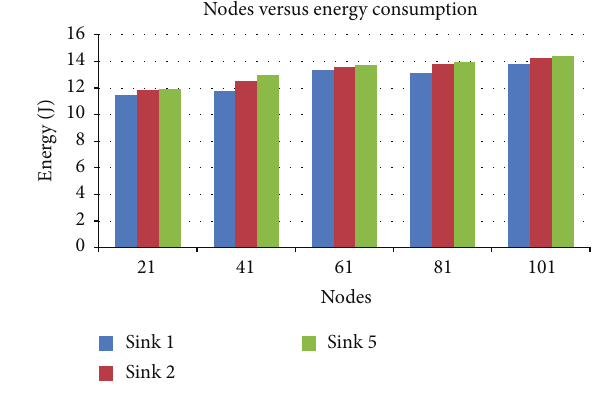
Figure 6: Nodes versus energy in terms of sink.